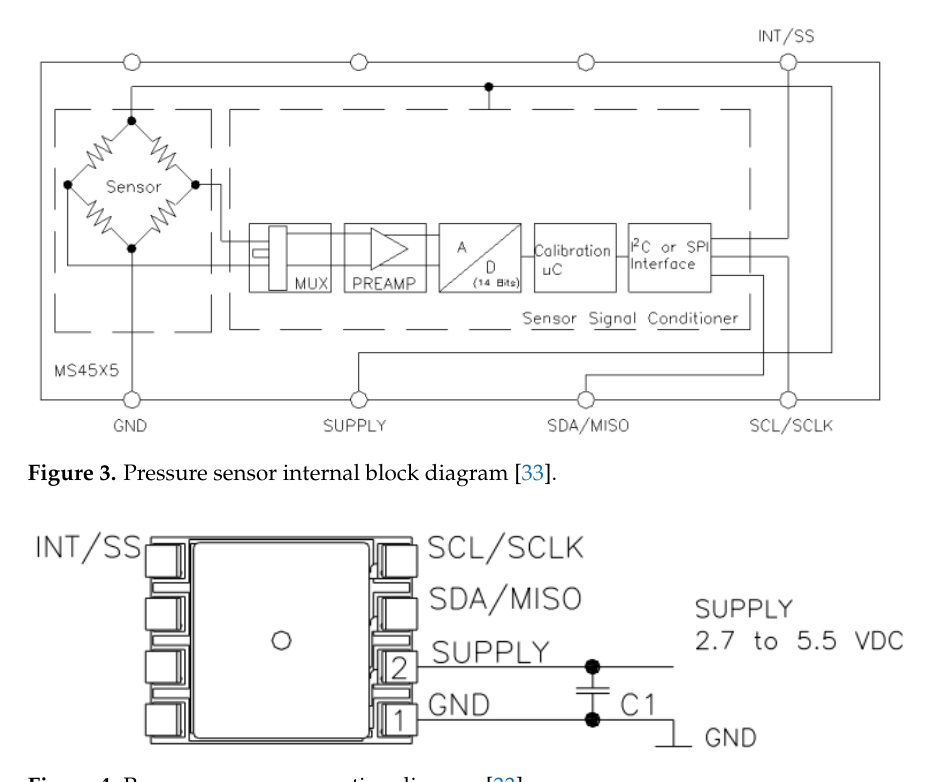
Figure 4. Pressure sensor connection diagram [33].